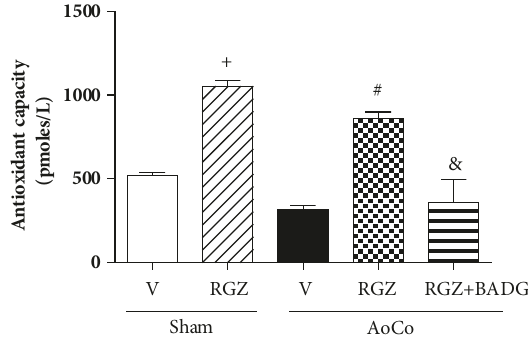
Figure 7: Effect of rosiglitazone (RGZ) on total antioxidant capacity of sham or aortic coarctated (AoCo) rats treated with vehicle (V), rosiglitazone(5mg/kg, RGZ), or RGZ + bisphenol A diglycidyl ether (120 mg/kg, RGZ+BADGE). The parameterwas evaluatedin serum. The values represent the mean ± SEM (n=6 animals of group). One- way analysis of variance (ANOVA) post Tukey. + P < 0.05 Sham-V vs. Sham-RGZ, ∗ P < 0.05 Sham-V vs. AoCo-V, # P < 0.05 AoCo-V vs. AoCo-RGZ, and & P < 0.05 AoCo-RGZ vs.